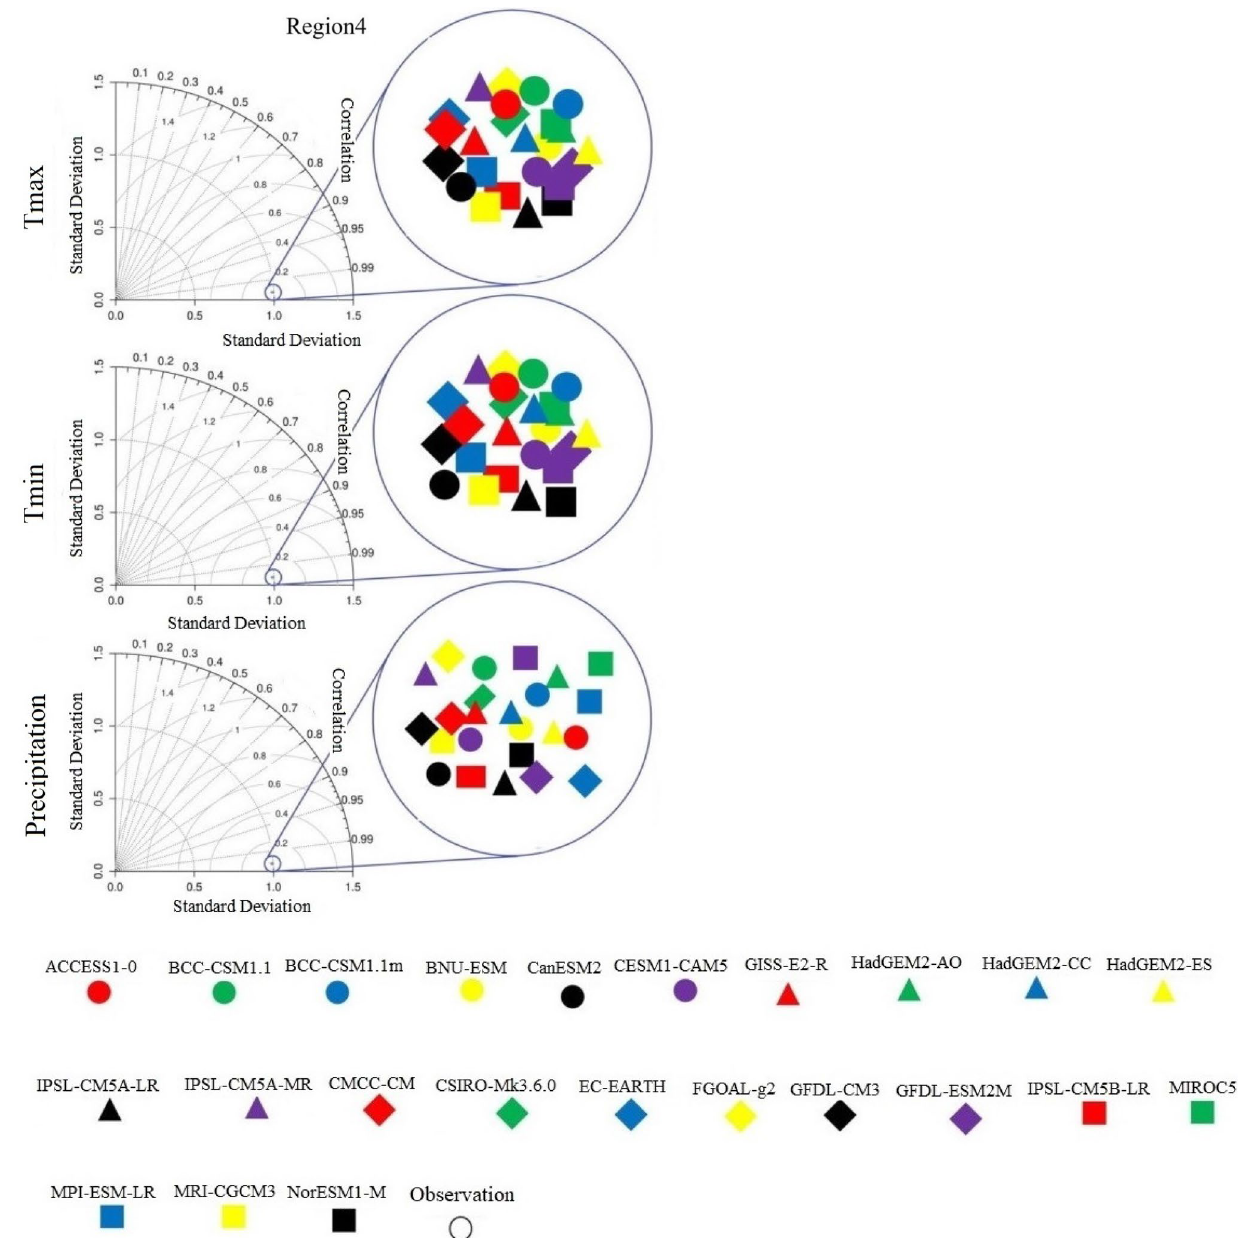
Fig. 16 Taylor diagrams for PCP, Tmax, and Tmin in region 4 in the baseline period